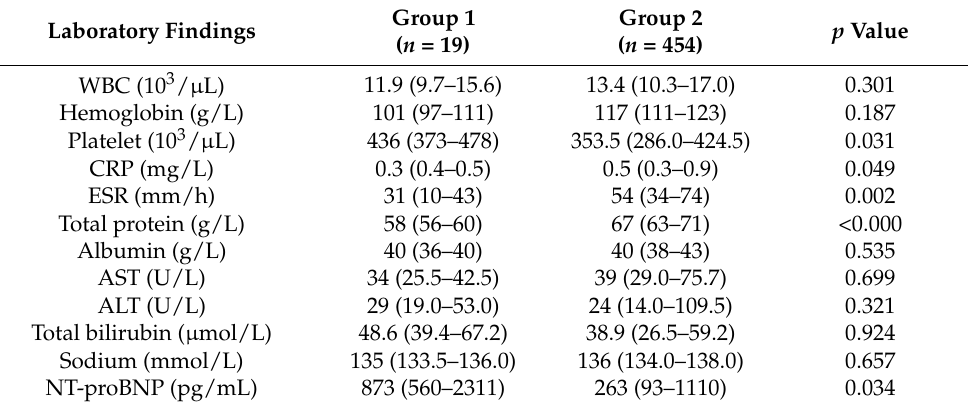
Table 2. Comparison of laboratory findings of two groups on the first day of